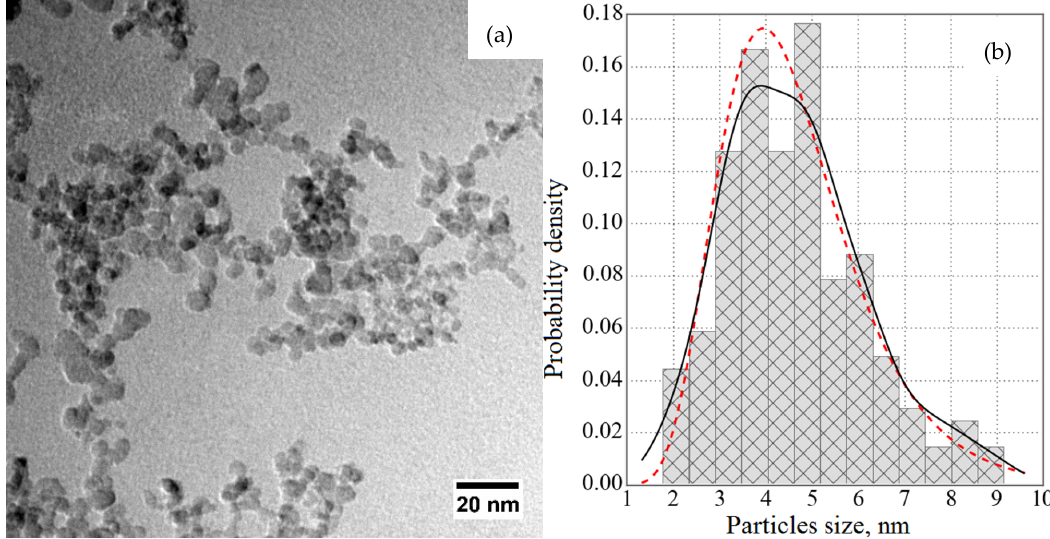
Figure 1. ( a ) A TEM image of the fluorinated nanodiamonds (F-DND) sample, ( b ) a corresponding diameter distribution of the DNDs. The red dashed line corresponds to the lognormal distribution. The black solid line indicates a data fitting.